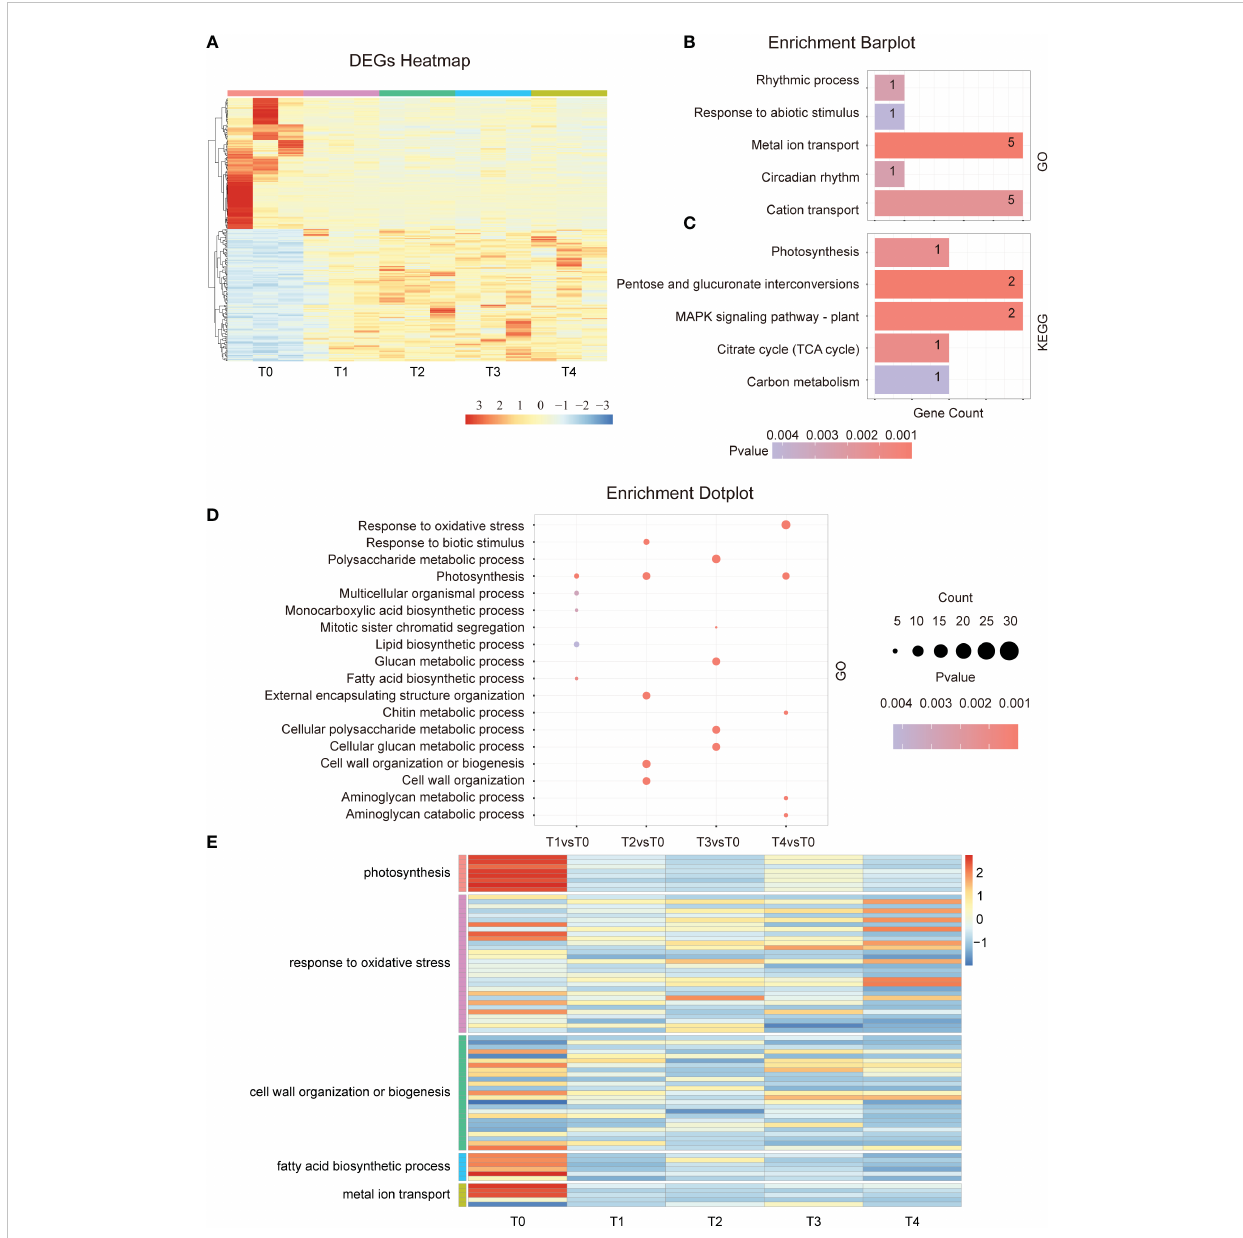
FIGURE 2 Differential gene expression in the early stage of Cd treatment. (A) . Hierarchical clustering heat map showing the gene expressions of a total of 15 samples at each time point during the early phase of Cd stress treatment (T0-T4). (B) . GO term enrichment analysis of common DEGs after cadmium treatment (T1vsT0, T2vsT0, T3vsT0, and T4vsT0). The top 5 entries were selected for shown. (C) . KEGG analysis of common DEGs after cadmium treatment (T1vsT0, T2vsT0, T3vsT0, and T4vsT0). The top 5 entries were selected for statistical analysis. (D) . GO enrichment results of differentially expressed genes at each time point (T1-T4) in the early phase of the Cd stress response. The top 3 entries for each time signi fi cance were selected for statistical analysis. (E) . The heat map shows the gene expression in photosynthesis, response to oxidative stress, cell wall organization or biogenesis, fatty acid biosynthetic process, and metal ion transport at the early stage of cadmium stress